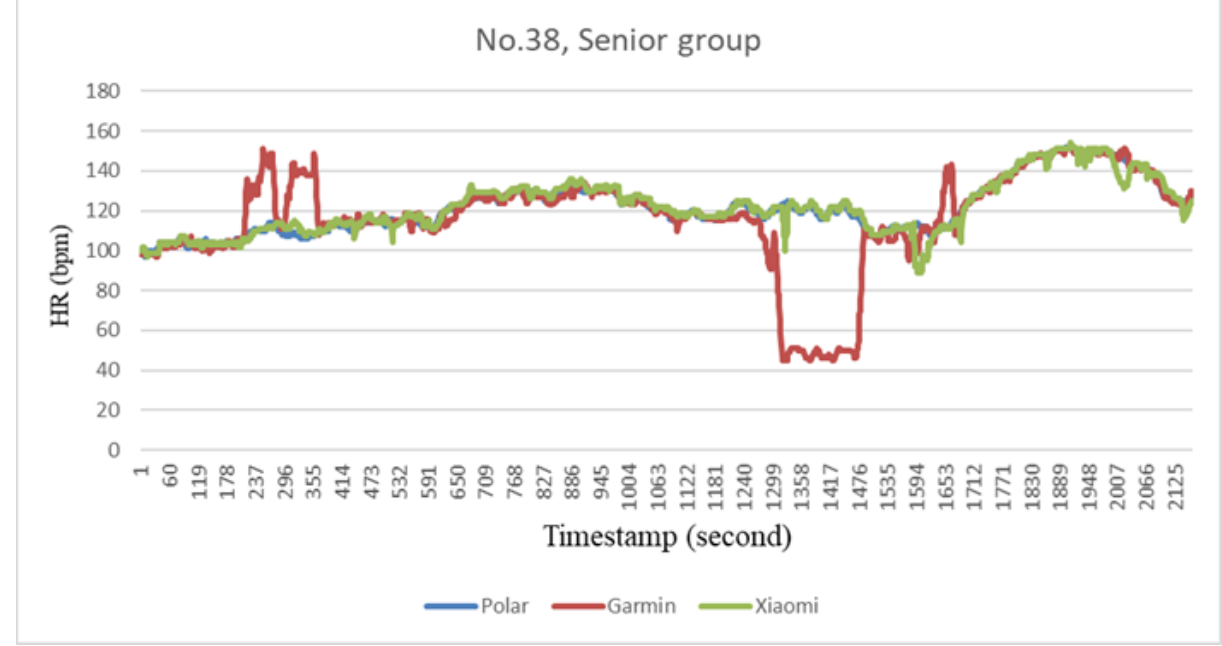
Figure 4. Subject-specific recording errors during the cycling